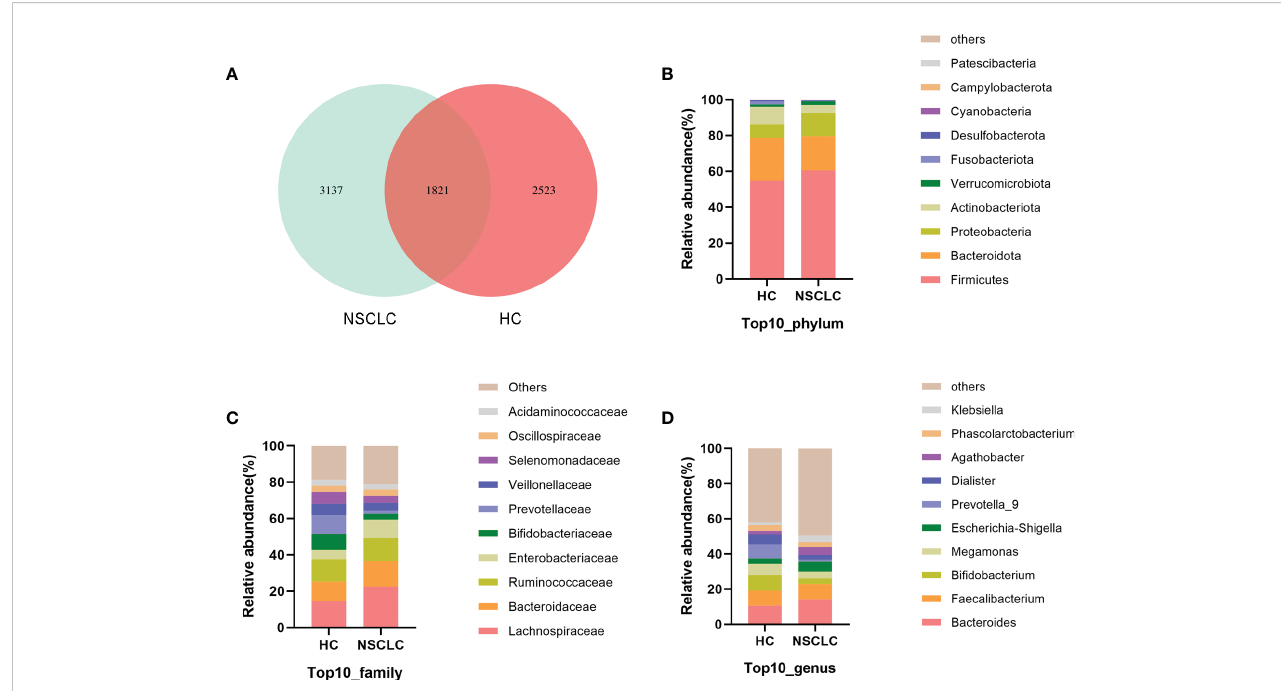
FIGURE 1 The characteristics of gut microbiota community structure (A) The Venn diagram shows unique and common ASVs in early-stage NSCLC and HC. (B – D) The top 10 representative species and their proportions in the two groups at the level of phylum (B) , species (C) , and genus (D)